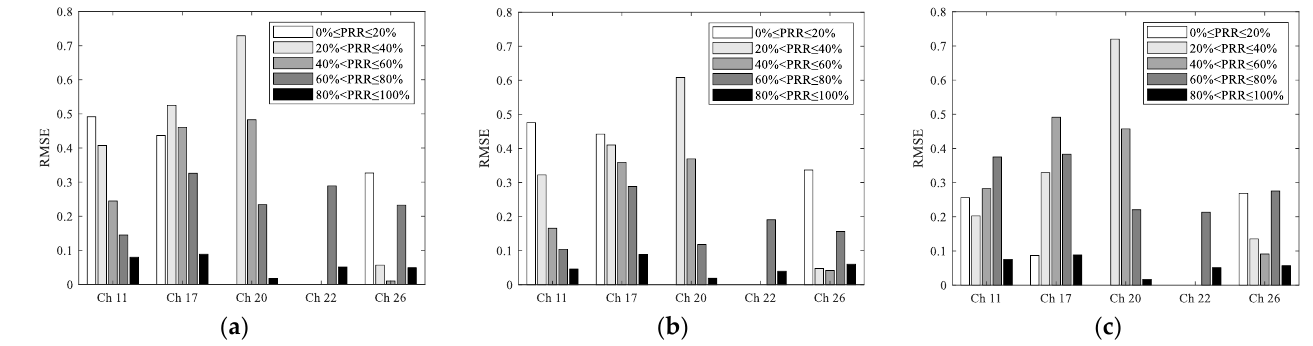
Figure 6. RMSEs of the LR-RSSI model, PN-RSSI model, and TH-RSSI model under different channels: ( a ) RMSE of the LR-RSSI model for different PRR ranges; ( b ) RMSE of the PN-RSSI model for different PRR ranges; ( c ) RMSE of the TH-RSSI model for different PRR ranges.